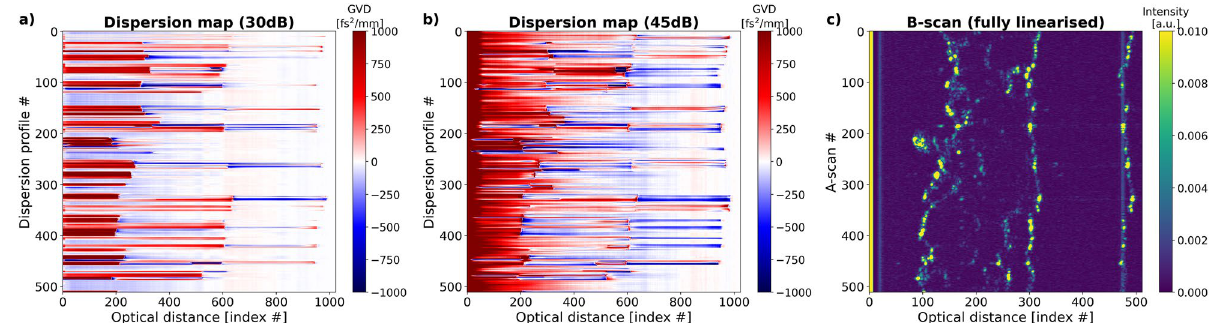
Figure 8. Dispersion maps of a cucumber obtained using the neural network trained with signals with ( a ) SNR = 30 dB, ( b ) and SNR=45dB show the boundaries of the imaged object, but the predicted GVD levels remain random. ( c ) The image of the cucumber. The twice bigger length of the x axis in the dispersion maps is a by-product of the FFT stack